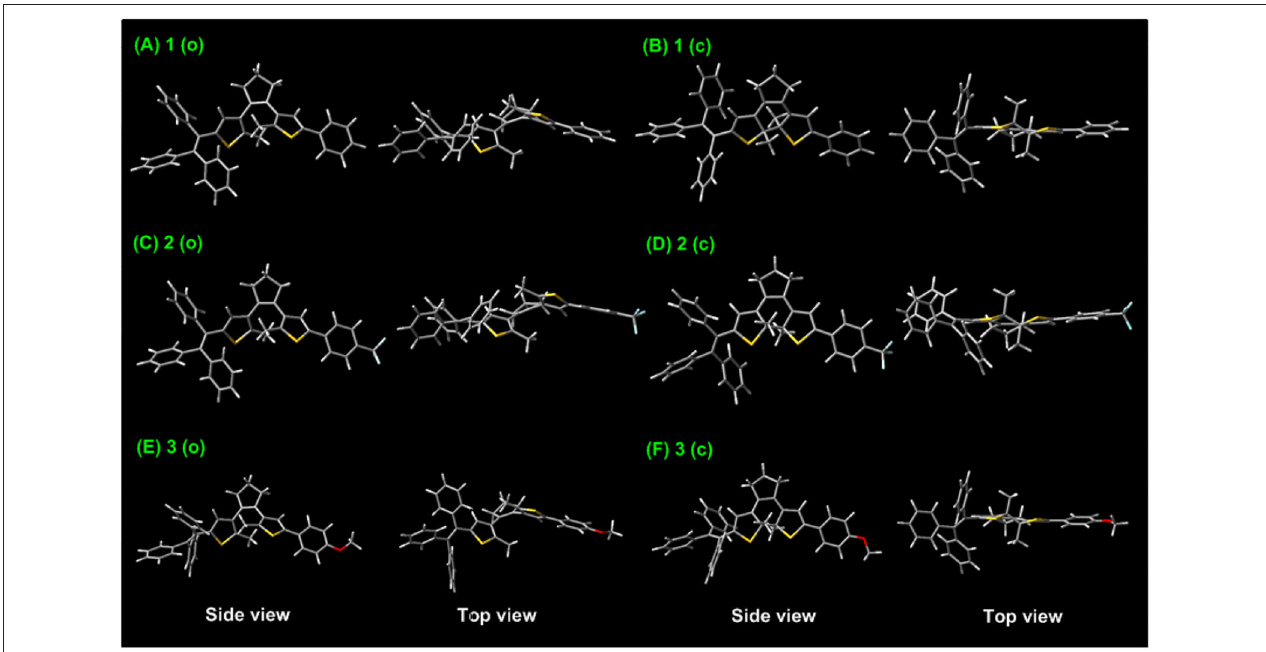
FIGURE 5 | Optimized ground-state geometry of dithienylethenes 1–3 based on DFT calculations at the B3LYP/6-31G* level by using the Gaussian 09 program, (A) ring-open isomer 1 (o); (B) ring-closed isomer 1 (c); (C) ring-open isomer 2 (o); (D) ring-closed isomer 2 (c); (E) ring-open isomer 3 (o); (F) ring-closed isomer 3